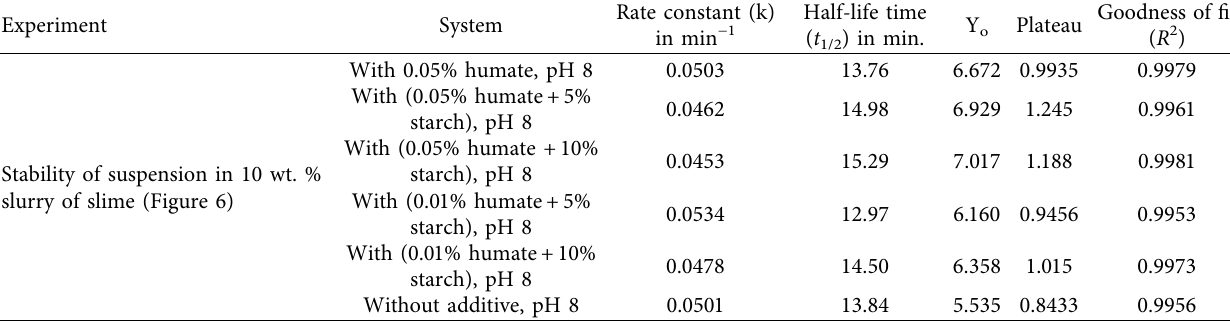
Table 6: Values of the parameters of equation (1) for beneficiation of 10 wt. % slurry of slime. Experiment System Plateau